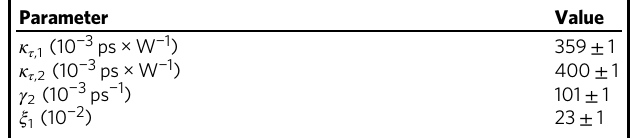
Table 1 Parameters obtained from